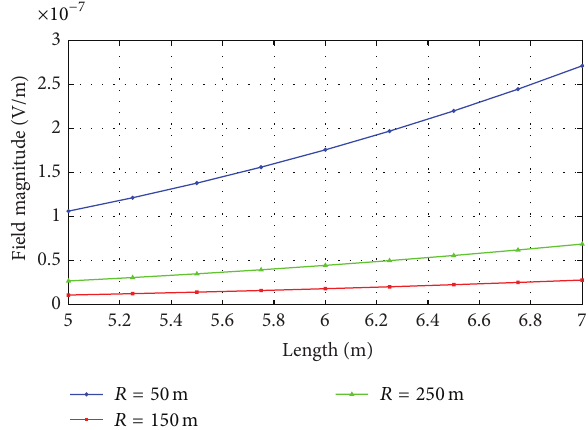
Figure 11: Curves of the radial component of the electric field magnitude with the antenna length.